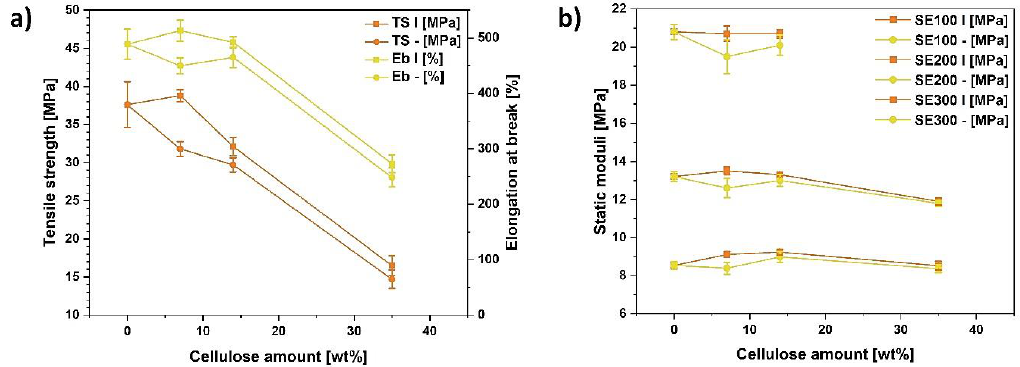
Figure 3. Tensile properties comparison presented as a function of modified cellulose fibers (ND/MA/1/E) amount: ( a ) tensile strength (TS) and elongation at break (Eb); ( b ) moduli (SE) at elongations of 100%, 200% and 300%.